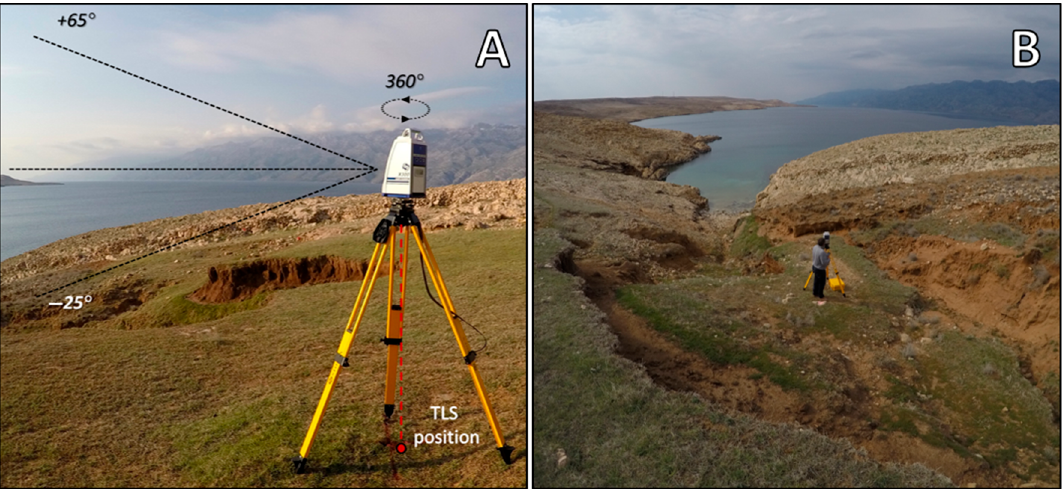
Figure 7. Stonex X300 TLS ( A ) used for the non-systematic TLS survey over gully Santiš ( B ) in